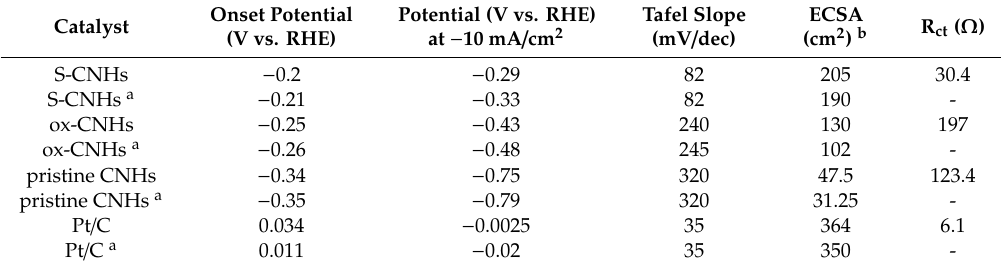
Table 2. Electrochemical parameters for HER.